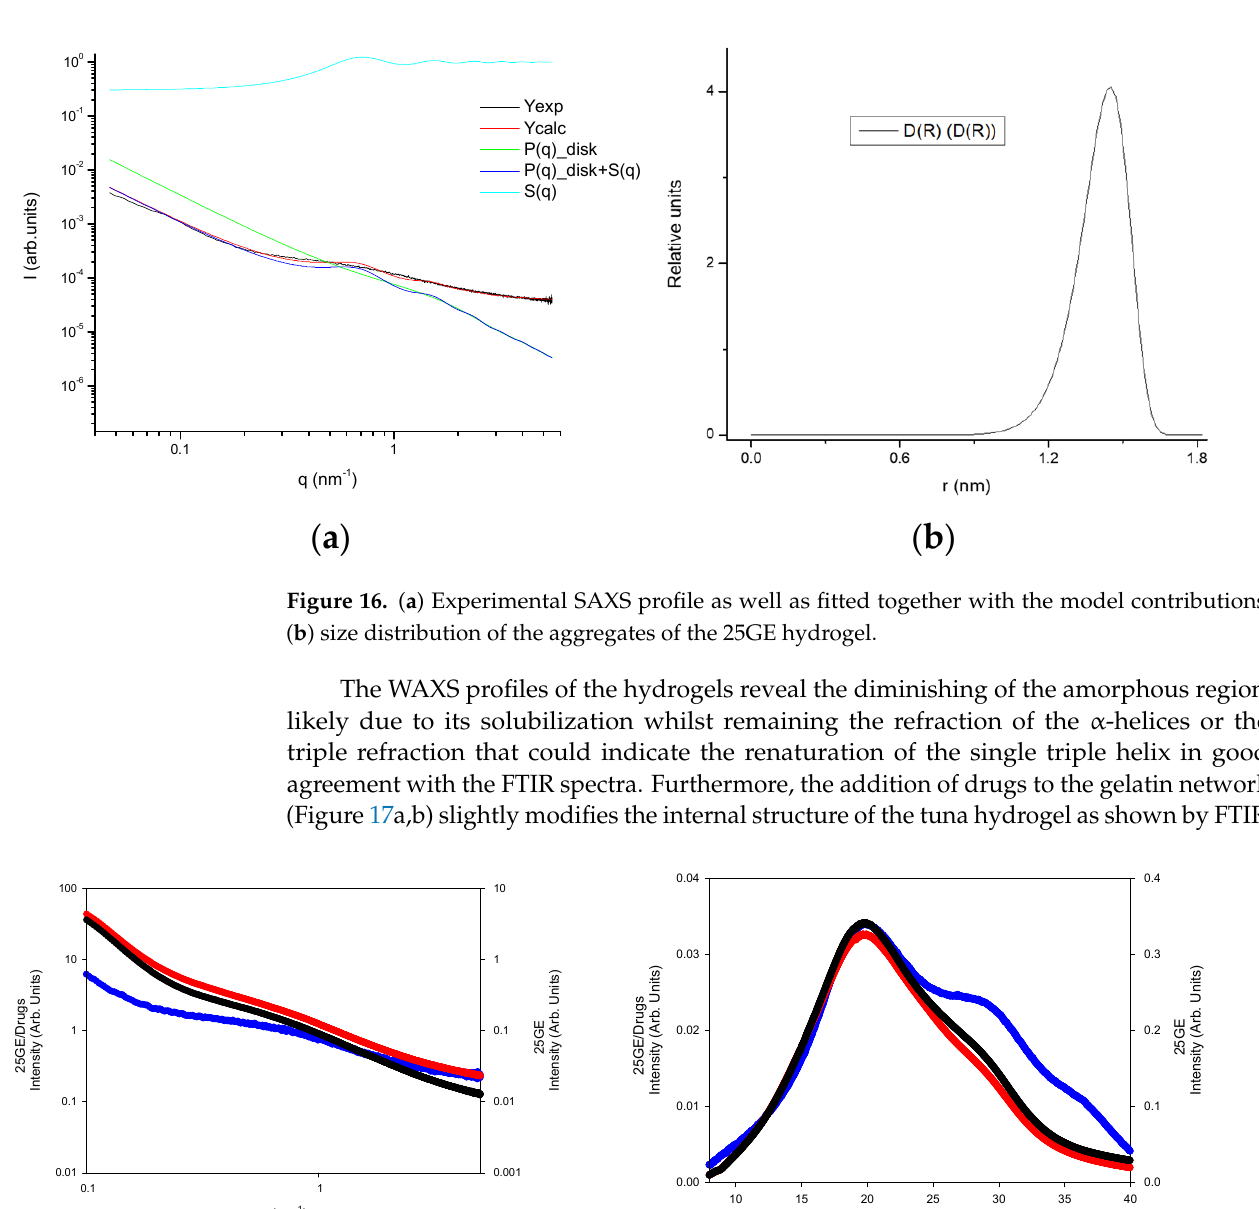
Figure 17. ( a ) SAXS and ( b ) WAXS of 25GE (blue line), 25GE/DOX (red line) and 25GE/Crocin (black line) at 25 ◦ C.